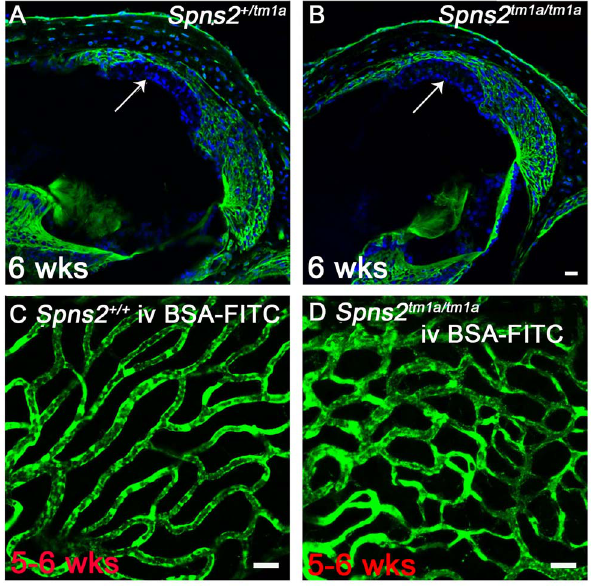
Figure 7. Normal strial integrity and normal permeability of strial capillaries to BSA-FITC. A,B , Endolymphatic and perilymphatic compartments were perfused by Sulfo-NHS-LC-Biotin. Biotin was detected by FITC-conjugated streptavidin (green) in frozen sections of 6 week old mice. No sign of biotin entry into the stria vascularis compartment was found as shown by the arrow indicated that the tight junctions of marginal and basal cells are sealed in Spns2 tm1a/tm1a mice ( B ) compared with the control mice ( A ). C,D , Stria vascularis capillaries of young adult wildtype ( C ) and Spns2 tm1a/tm1a ( D ) mice following BSA- FITC injection into the tail vein, showing no evidence of leakage of the tracer (green) out of the capillaries. The increased branching of capillaries in these Spns2 tm1a/tm1a mice is also visible. Scale bars, 20 m m in A–D .